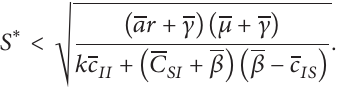
such that 𝐸 ∗ + ∈ 𝜕 B and 𝜕 B ∩ 𝜕 R 2 + ̸= 0 . Indeed, any